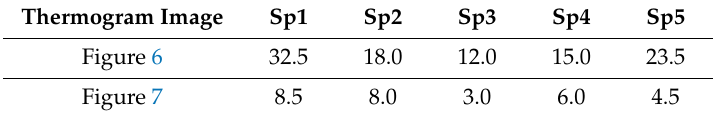
Table 4. The temperature ( ◦ C) of spots on the Quercus pyrenaica thermograms (Figures 6 and 7).